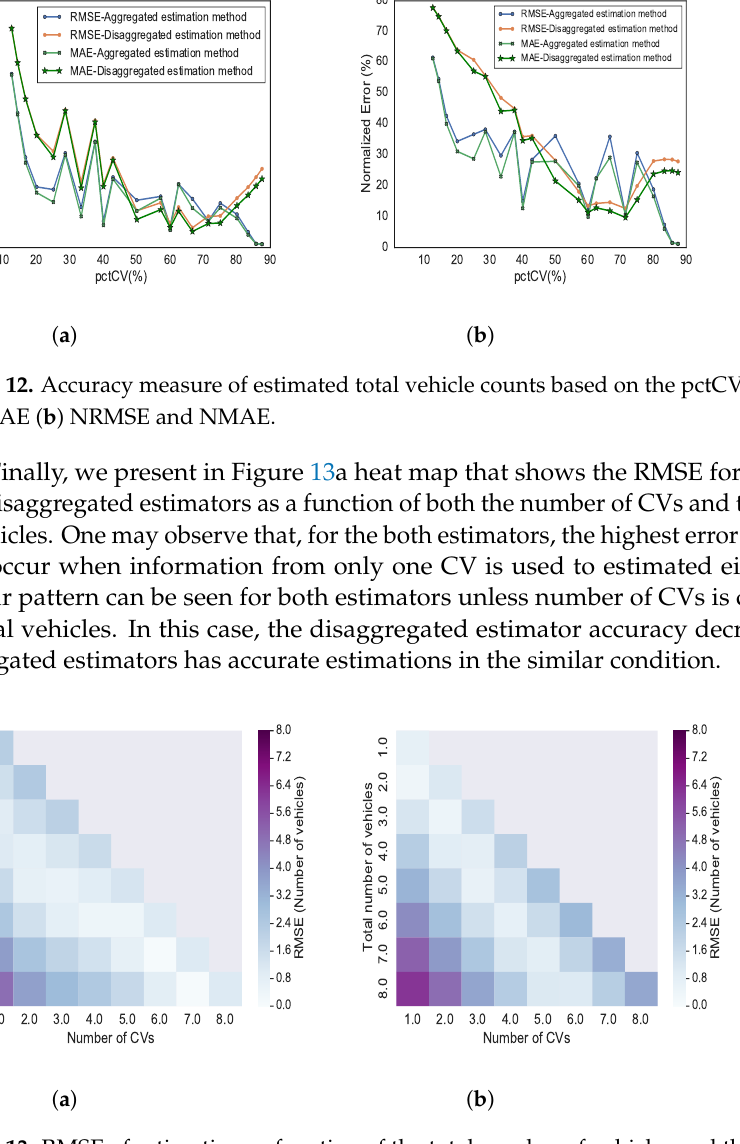
Figure 13. RMSE of estimation as function of the total number of vehicles and the number of CVs ( a ) Aggregated estimator ( b ) Disaggregated